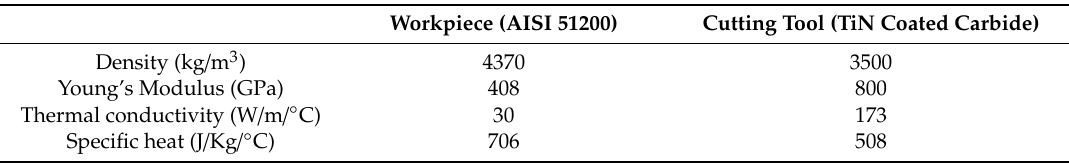
Table 1. Workpiece and cutting tool properties.